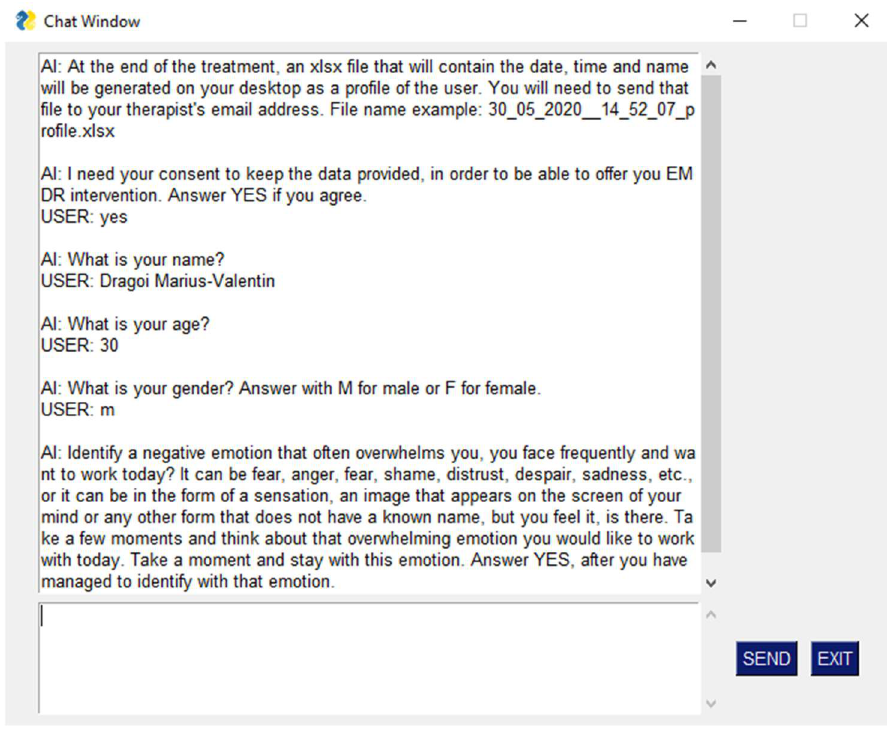
Figure A1. Chat window used for communication between the chatbot module and users.